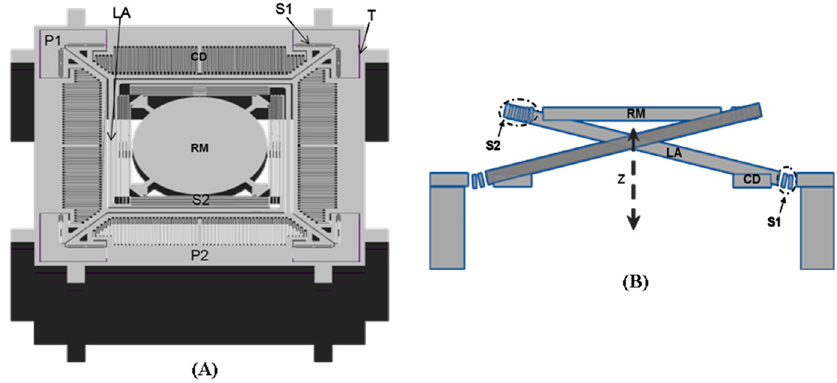
Figure 2. Schematics for out-of-plane translational MEMS scanner with a level-based compliant mechanism. ( A ) Front view of the basic structure; ( B ) cross-section view of the out-of-plane